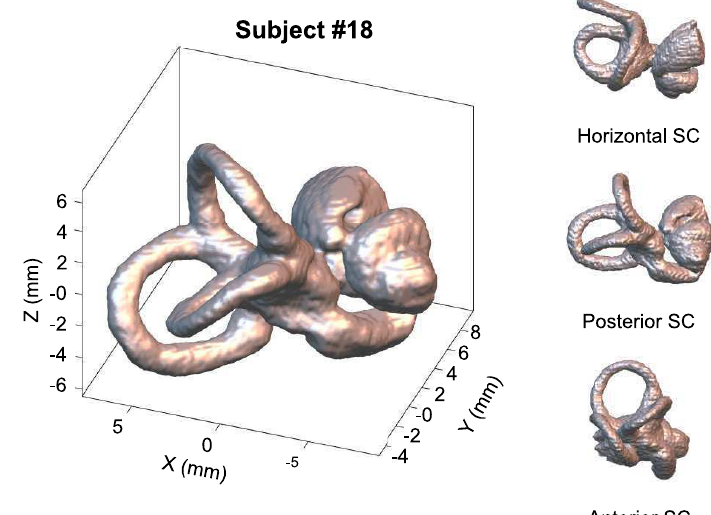
Figure 6. 3D semicircular ducts reconstruction from the 3D high-resolution MRI scan of Volunteer 18: ( left ) the whole SCs reconstruction where we can easily locate the three ducts; and ( right ) various views the show, from top to bottom, the Horizontal SC (HSC), Posterior SC (PSC) and Anterior SC (ASC), respectively.